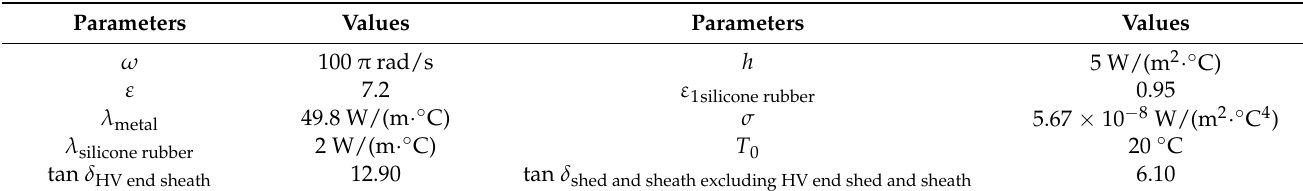
Table 5. Electrical and thermal characteristic values of the used